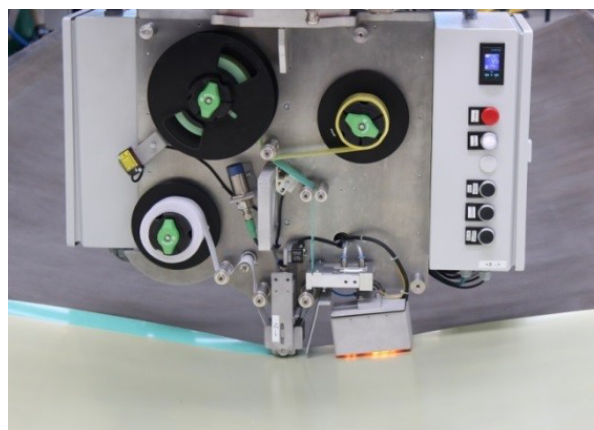
Figure 6: Solutions for the requirements of an adhesive end effector, © Fraunhofer